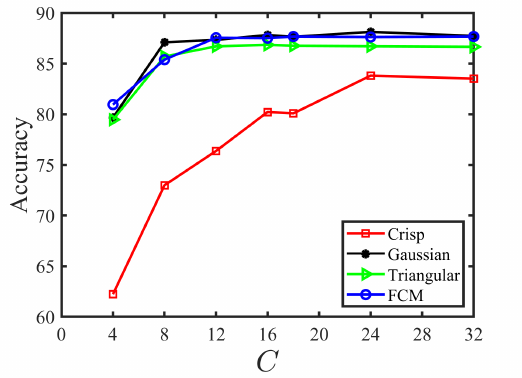
Figure 6. Average accuracy (%) vs. number of colors ( C ) for different membership